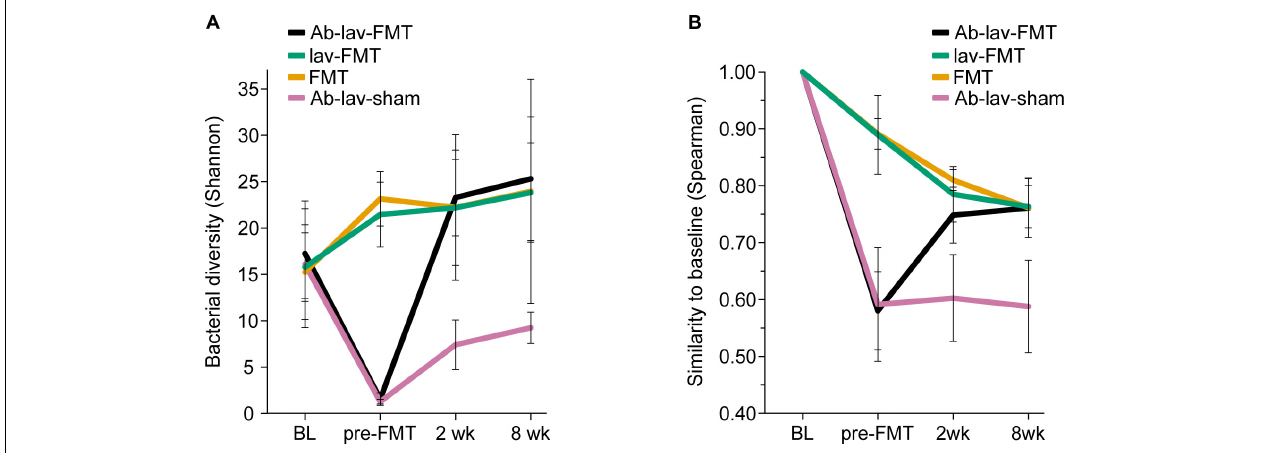
FIGURE 3 | (A) Bacterial diversity in different treatment groups across all time points. (B) Similarity between the baseline sample and consecutive samples in all study groups across all time